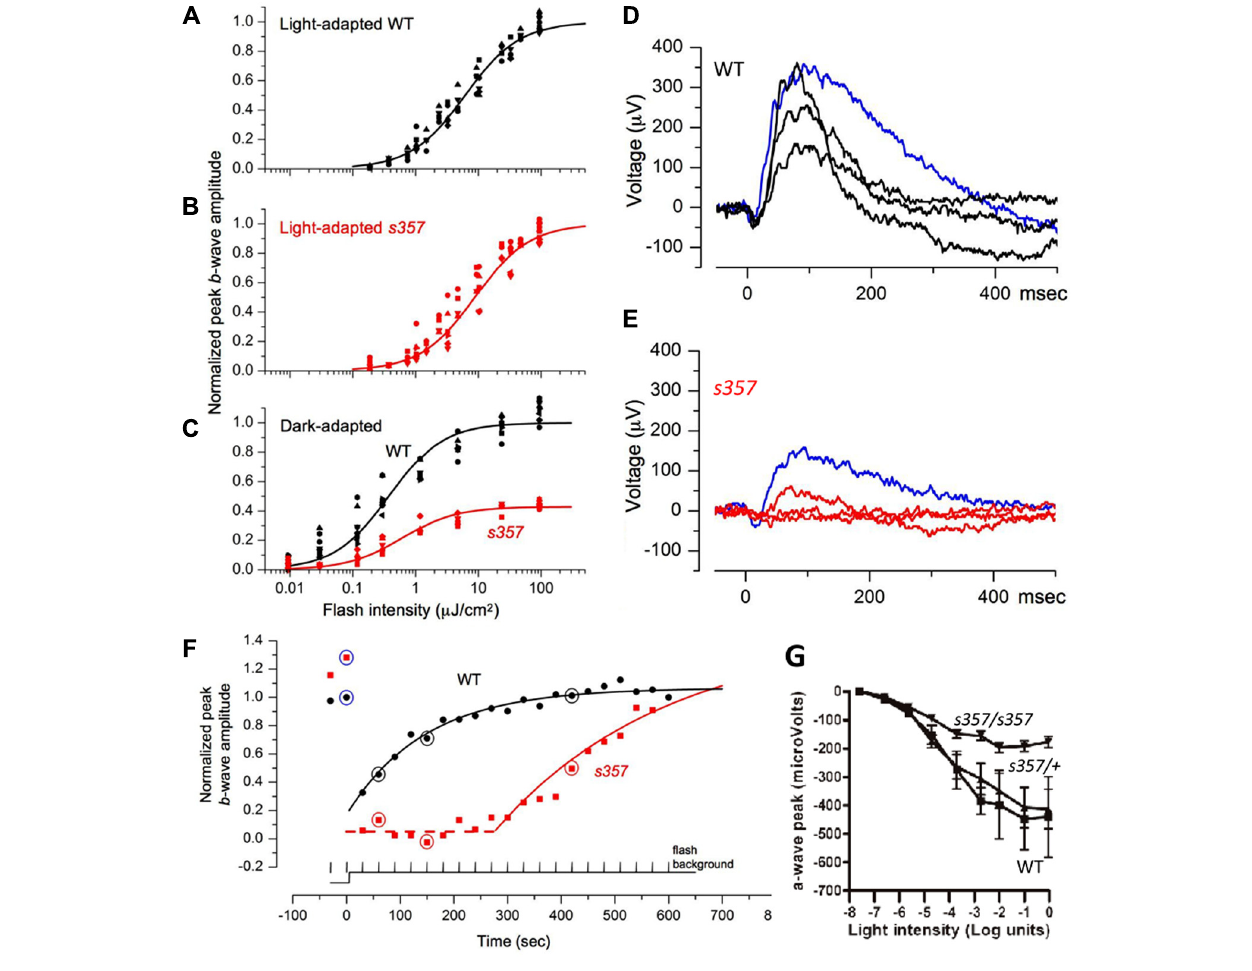
FIGURE 2 | Electrophysiological evidence for visual defects in gr s357 mutants. (A–C) Normalized light sensitivity plots of light-adapted WT ( A ; n = 9) and mutant ( B ; n = 11) larvae, and dark-adapted WT ( n = 8) and mutant ( n = 5) larvae (C) at 7 dpf, fitted by the Naka-Rushton function (see Materials and Methods). Normalized peak amplitudes in the dark-adapted mutants were further normalized to wild type (C) . (D–F) Representative incremental flash ERG traces from WT (D) and mutant (E) larvae. Dark- adapted larvae were presented two 20 ms test flashes (blue traces; 9.6 μ J/cm 2 , nearly saturated peak amplitude) prior to the onset of continuous background illumination (121 μ J/cm 2 s) followed by 20 test flashes at 30 s intervals. WT ( D , black) and mutant ( E , red) traces are ERG